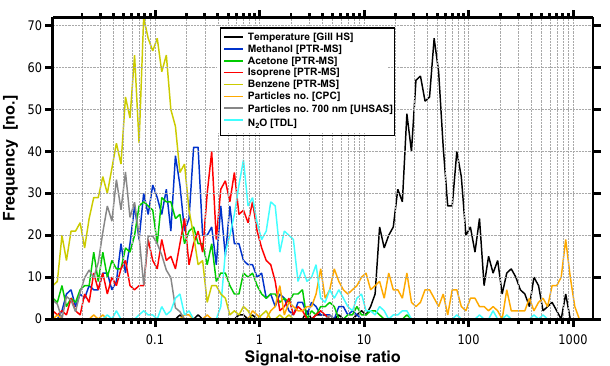
Figure 4. Signal-to-noise ratios of typical instruments used for the flux measurement of various trace gases and aerosols. Analysers include a sonic anemometer (temperature) and PTR-MS (isoprene, methanol and acetone) operated above a mixed oak forest at a height of 32m and above a city (benzene). Particle number concentrations were measured by a CPC and UHSAS (single size bin) above a Dou- glas fir forest and N 2 O measurements were made above a grassland field in 2003 using a first-generation tuneable diode